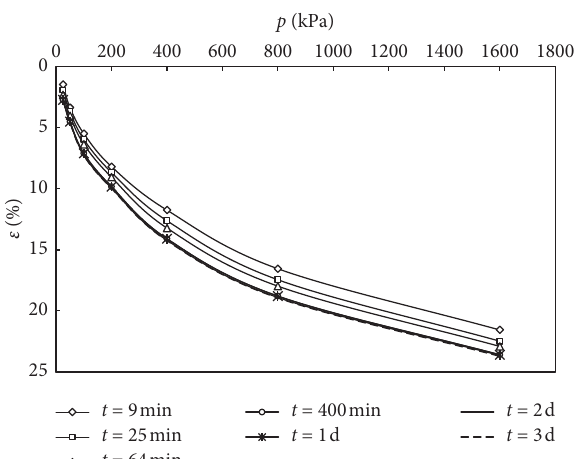
Figure 6: Isochronous curves of stress-strain relationship for test no.